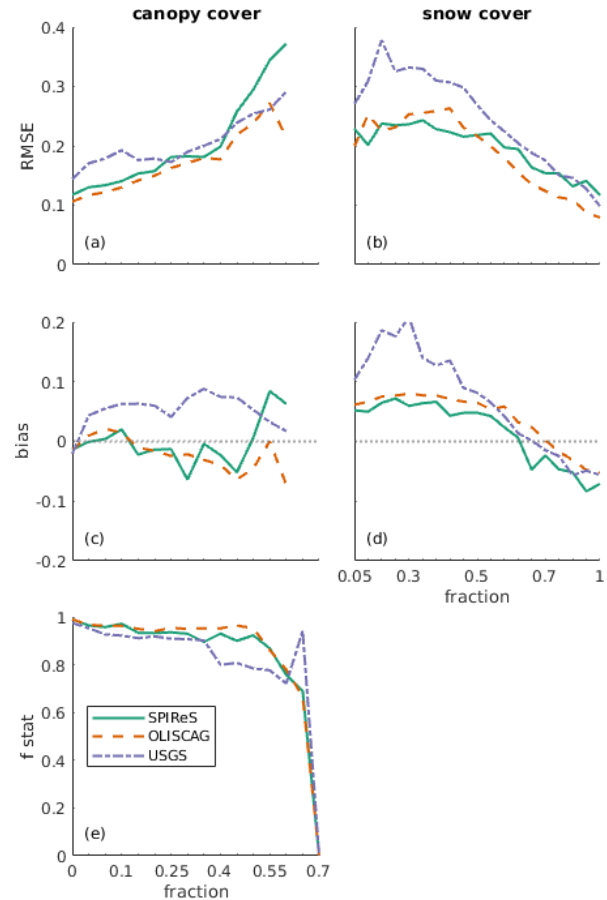
Figure 4. Snow cover mapping statistics: RMSE (a, b) , bias (c, d) , and F -statistic (e) values calculated for pixels binned by canopy cover fraction (a, c, e) and by ASO-derived snow cover fraction (b, d) from Landsat 8 fractional snow cover products (SPIReS, USGS, and OLISCAG). No F -statistic graph is displayed for the snow- covered area due to the low F -statistic variability associated with the snow cover